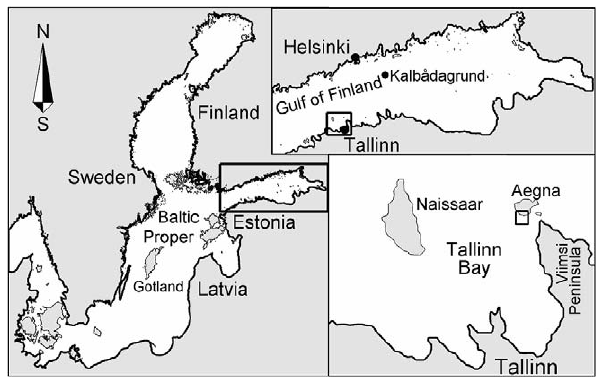
Figure 1. The Baltic Sea, Tallinn Bay, the study site on the SW coast of Aegna (right lower Fig. 1. The Baltic Sea, Tallinn Bay, the study site on the SW coast panel). of Aegna (right lower